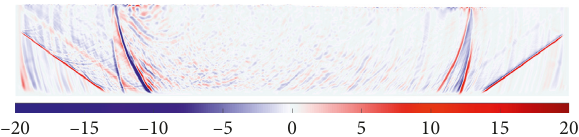
Figure 16: Velocity distribution in the x direction at time � 70s.